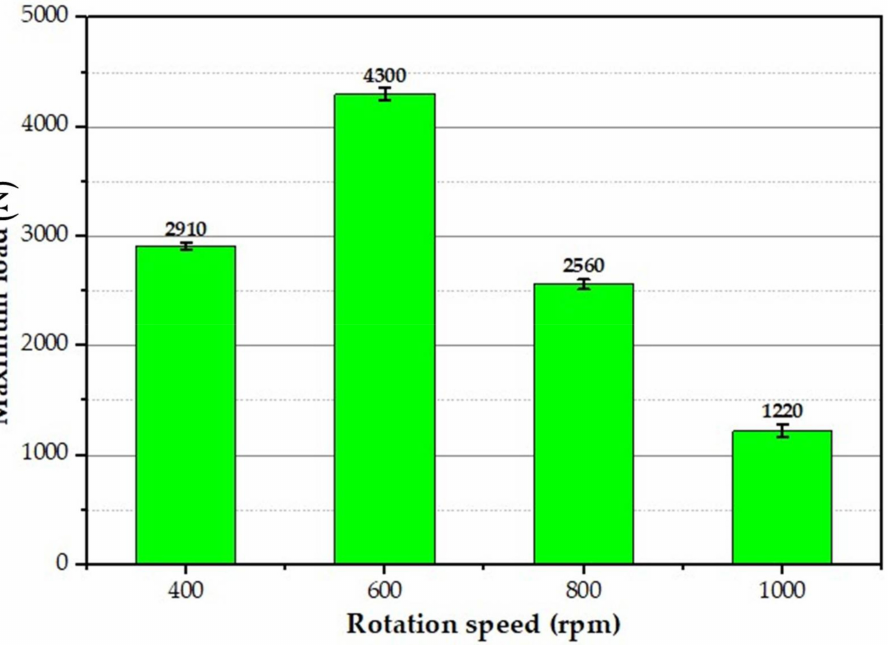
Figure 17. Maximum t ensile-shear load of the FSSWed joints processed at a constant dwell time of 3 s and different rotation speeds of 400, 600, 800, and 1000 rpm.